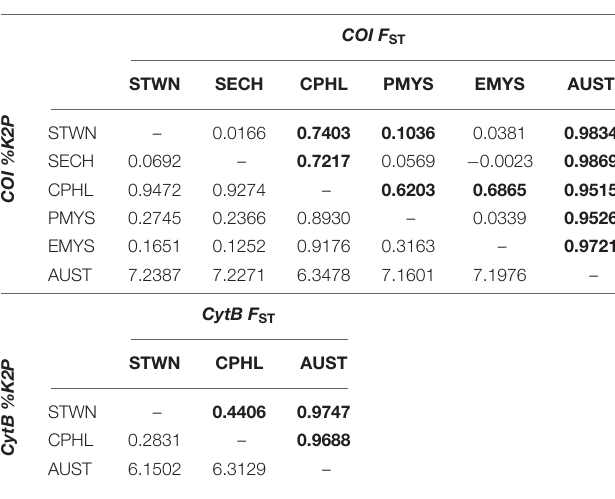
TABLE 2 | Polymorphic sites (PS), haplotype diversity (Hd), nucleotide diversity ( π ), and Tajima’s D and Fu’s Fs indices for cytochrome oxidase I (COI) and cytochrome B (CytB).